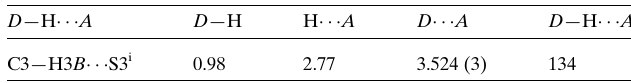
Table 2 Hydrogen-bond geometry (A˚ , (cid:5) ) for II .